Question: State the chart type depicted above.
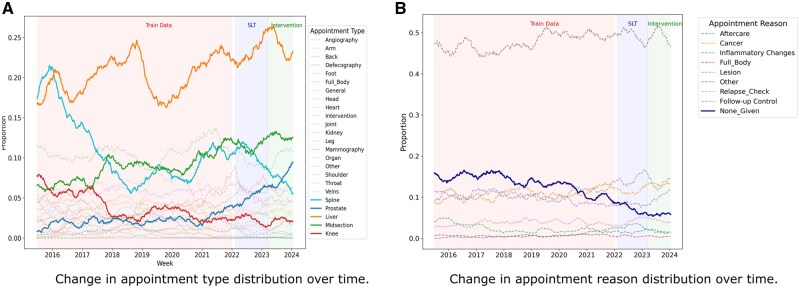
Answer: line